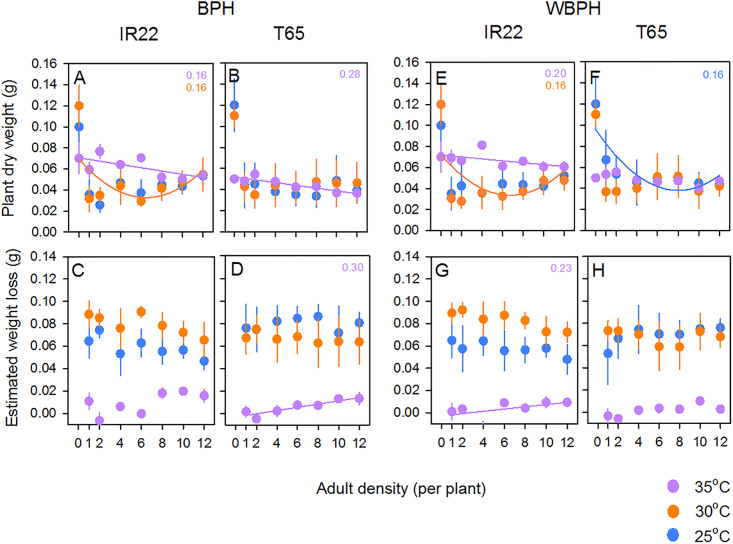
Effects of adult planthoppers on rice seedlings at three temperatures.The biomass of (A) IR22 seedlings and (B) T65 seedlings without exposure to planthoppers (density = 0) and after exposure to adult female BPH at densities ranging from 1 to 12 per plant are presented. Corresponding losses to the biomass of (C) IR22 and (D) T65 at different densities of adult BPH under the same conditions are also presented. Plants and planthoppers were maintained at three temperatures (25°C [blue symbols], 30°C [orange symbols] and 35°C [purple symbols]). The biomass of (C) IR22 and (B) T65 seedlings after exposure to adult WBPH females are presented with corresponding losses to (G) IR22 and (H) T65 due to WBPH adults. Standard errors are indicated (N = 5). Significant models and corresponding R2 values are included (colours as for symbols: see S6 and S7 Tables).